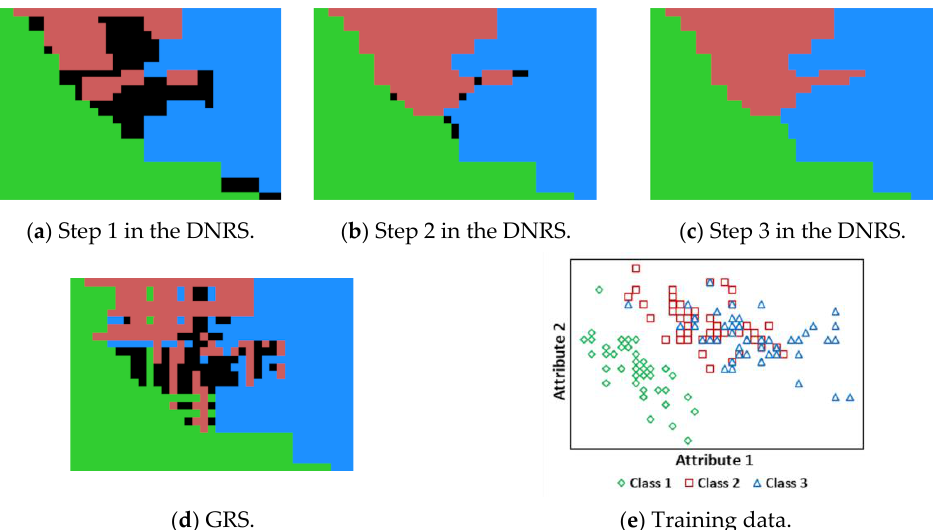
Figure 5. Visualized classification results of the DNRS and GRS in a two-dimension feature space using one of the 10-fold cross-validation datasets of attributes 1 and 2 in the Iris dataset. Black indicates unclassified.